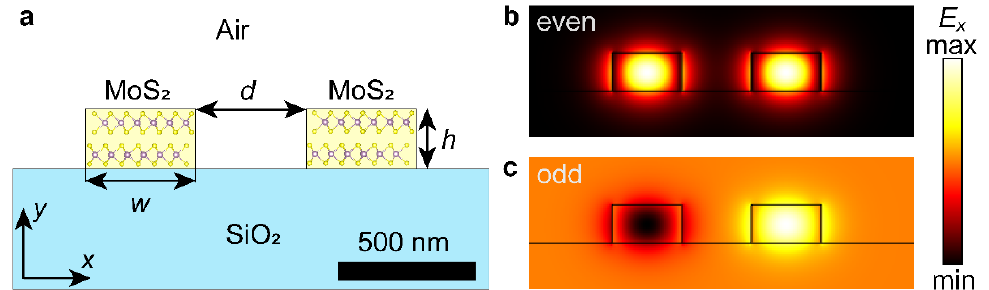
Figure 1. Structure for optimization. Schematic image of the structure ( a ) and linear-scale field distribution E x in the symmetric ( b ) and antisymmetric mode ( c ). Note that the orange color in panel c corresponds to zero whereas black and white colors represent negative and positive numbers of maximum absolute value. Waveguide dimensions are h = 220 nm, w = 400 nm and d = 400 nm.